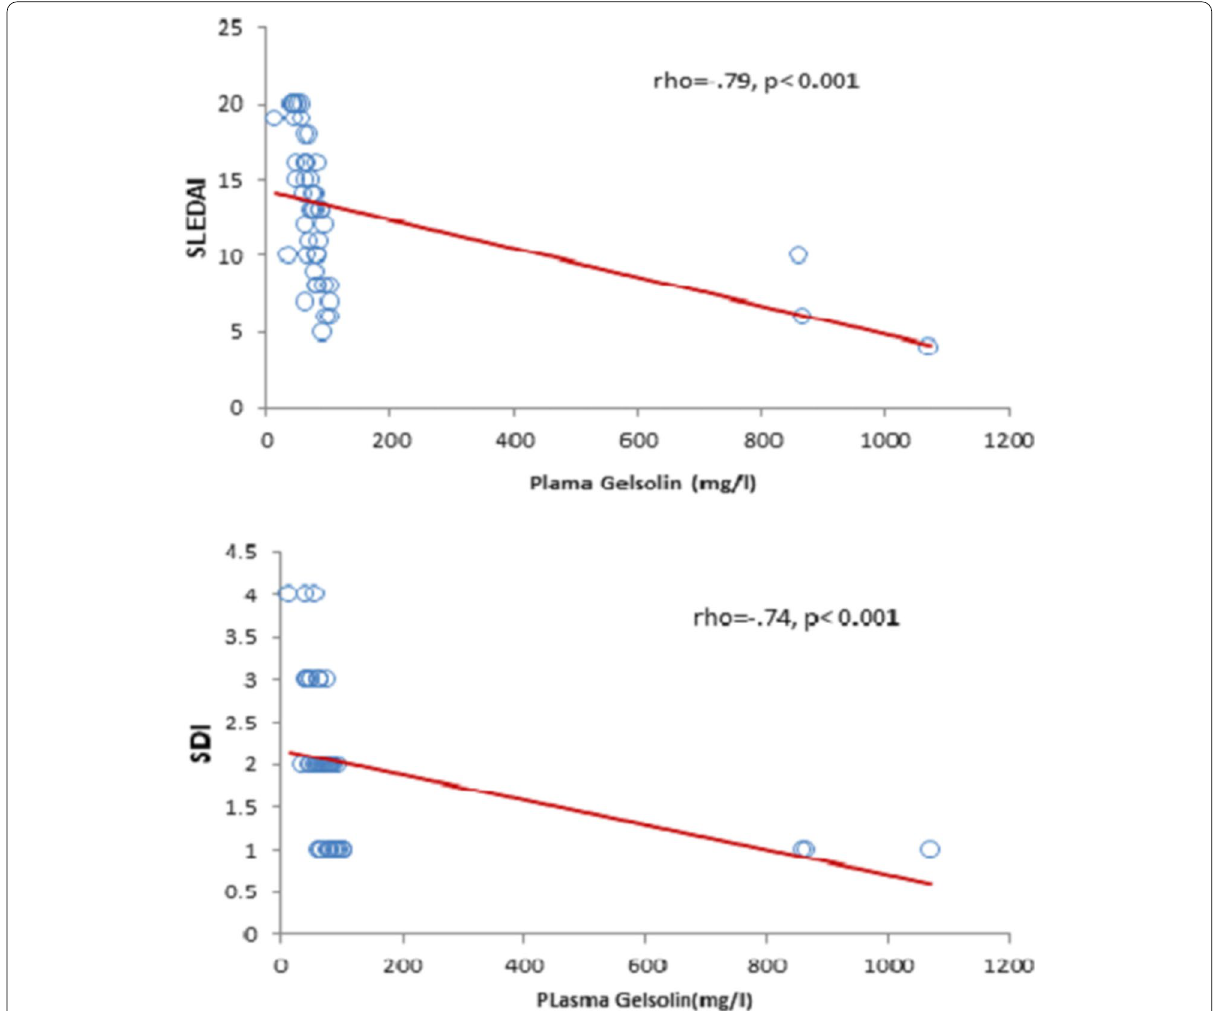
Fig. 2 Correlation of plasma gelsolin with the systemic lupus erythematosus disease activity index (SLEDAI) and SLE damage index (SDI) in SLE patients